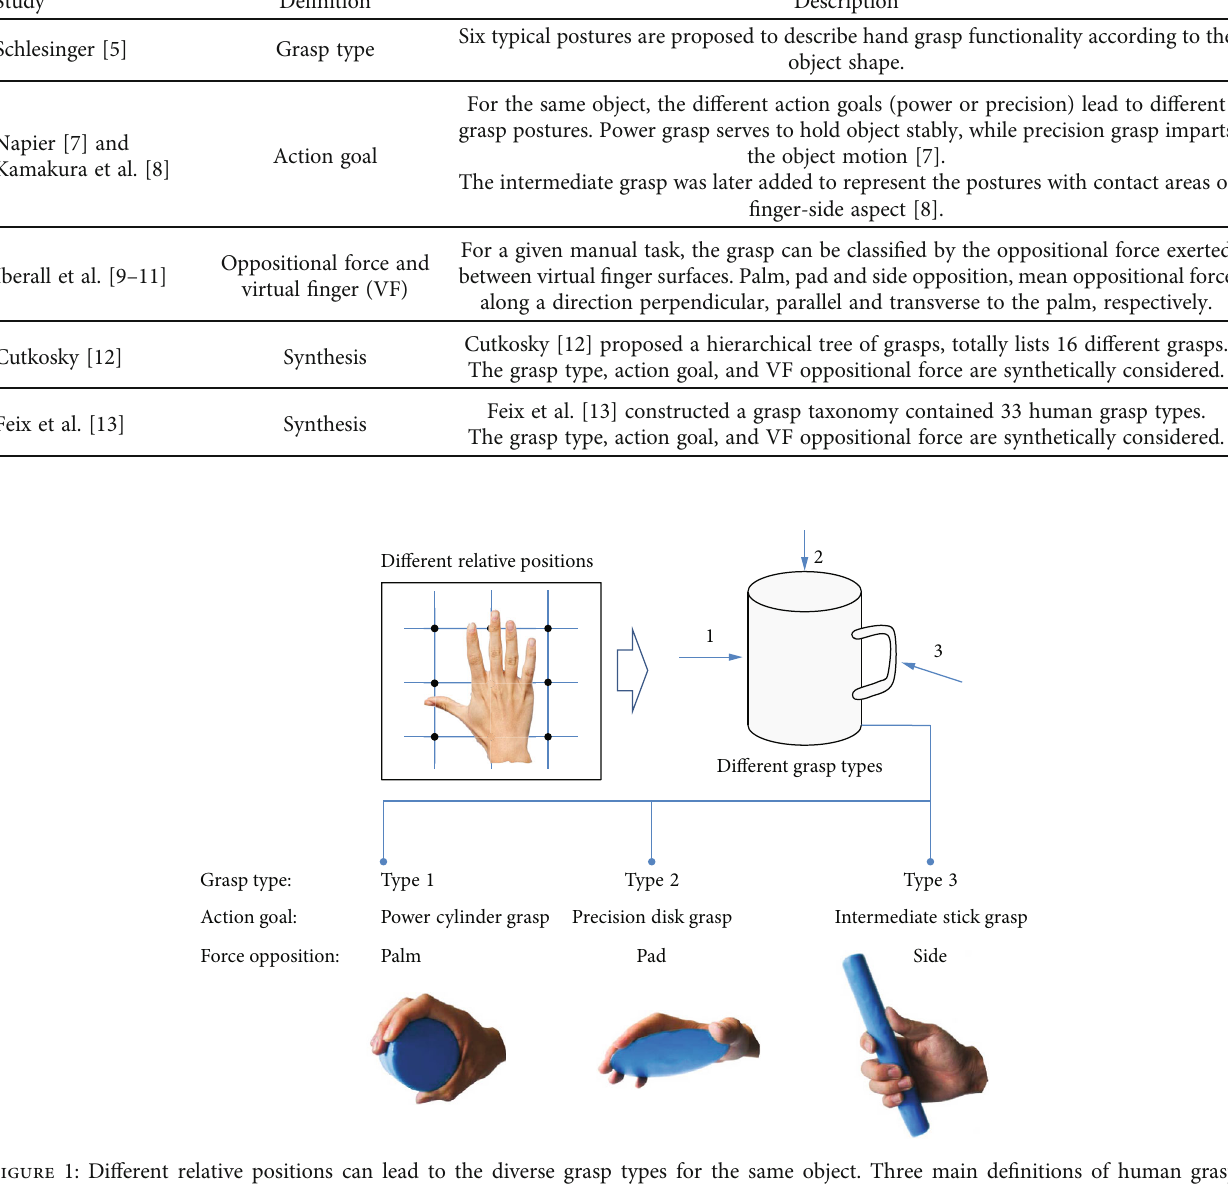
Figure 1: Di ff erent relative positions can lead to the diverse grasp types for the same object. Three main de fi nitions of human grasp classi fi cation are represented and covered by adjusting relative positions of